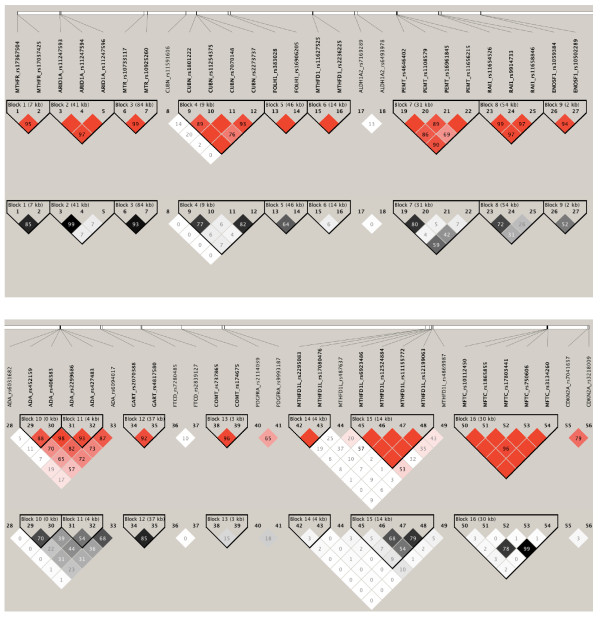
Linkage Disequilibrium Relationships Between SNPs Significantly Associated with NTDs. Sixty-eight SNPs were associated with case or maternal effects (p < 0.01, uncorrected). Of these, 56 SNPs occur in the same gene as at least one other significantly associated SNP. Their D’ (red scale) and r2 (gray scale) relationships are shown. These SNPs are plotted by relative position. Haplotype blocks defined by a Solid Spine of LD (D’) are outlined in black. Each SNP is numbered and the gene and dbSNP accession number for each are: 1) MTHFR_rs17367504; 2) MTHFR_rs17037425; 3) ARID1A_rs11247593; 4) ARID1A_rs11247594; 5) ARID1A_rs11247596; 6) MTR_rs10733117; 7) MTR_rs10925260; 8) CUBN_rs11591606; 9) CUBN_rs1801222; 10) CUBN_rs11254375; 11) CUBN_rs7070148; 12) CUBN_rs2273737; 13) FOLH1_rs383028; 14) FOLH1_rs16906205; 15) MTHFD1_rs11627525; 16) MTHFD1_rs2236225; 17) ALDH1A2_rs7169289; 18) ALDH1A2_rs6493978; 19) PEMT_rs4646402; 20) PEMT_rs1108579; 21) PEMT_rs16961845; 22) PEMT_rs11656215; 23) RAI1_rs11654526; 24) RAI1_rs9914733; 25) RAI1_rs11658846; 26) ENOSF1_rs1059384; 27) ENOSF1_rs10502289; 28) ADA_rs6031682; 29) ADA_rs452159; 30) ADA_rs406383; 31) ADA_rs2299686; 32) ADA_rs427483; 33) ADA_rs6094017; 34) GART_rs2070388; 35) GART_rs4817580; 36) FTCD_rs7280485; 37) FTCD_rs2839127; 38) COMT_rs737865; 39) COMT_rs174675; 40) PDGFRA_rs2114039; 41) PDGFRA_rs9993187; 42) MTHFD1L_rs2295083; 43) MTHFD1L_rs17080476; 44) MTHFD1L_rs487637; 45) MTHFD1L_rs6923486; 46) MTHFD1L_rs12524884; 47) MTHFD1L_rs11155772; 48) MTHFD1L_rs12199063; 49) MTHFD1L_rs4869987; 50) MFTC_rs10112450; 51) MFTC_rs1865855; 52) MFTC_rs17803441; 53) MFTC_rs750606; 54) MFTC_rs3134260; 55) CDKN2A_rs7041637; 56) CDKN2A_rs3218009